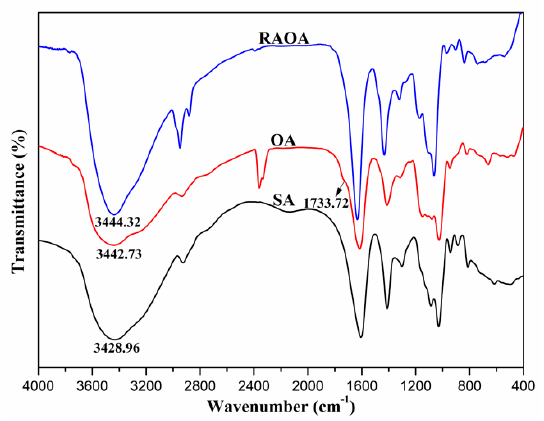
Figure 1. FT ‐ IR spectra spectra of SA, OA and RAOA. Figure 1. FT-IR spectra spectra of SA, OA and